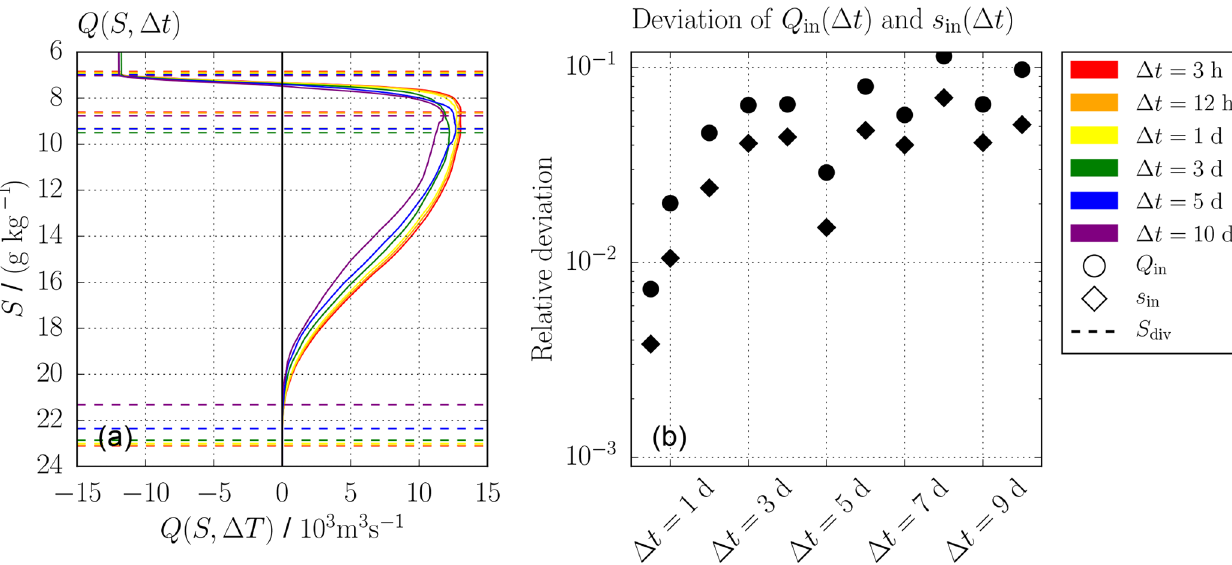
Figure 8. Exchange flow over Darss Sill: comparison of Q(S) ( N = 2 16 = 65536) for different (cid:49)t in panel (a) and the relative deviations of Q in and s in in dependency (cid:49)t to the bulk values for (cid:49)t = 3h in panel (b) . The bulk values were computed from Q((cid:49)t) using the extended dividing salinity method (11, 16). The dashed lines in panel (a) show the dividing salinities used to compute the bulk values in panel (b) . With different temporal resolutions, the shape of Q(S) changes considerably and the resulting bulk values deviate significantly from the ones for 3-hourly data.